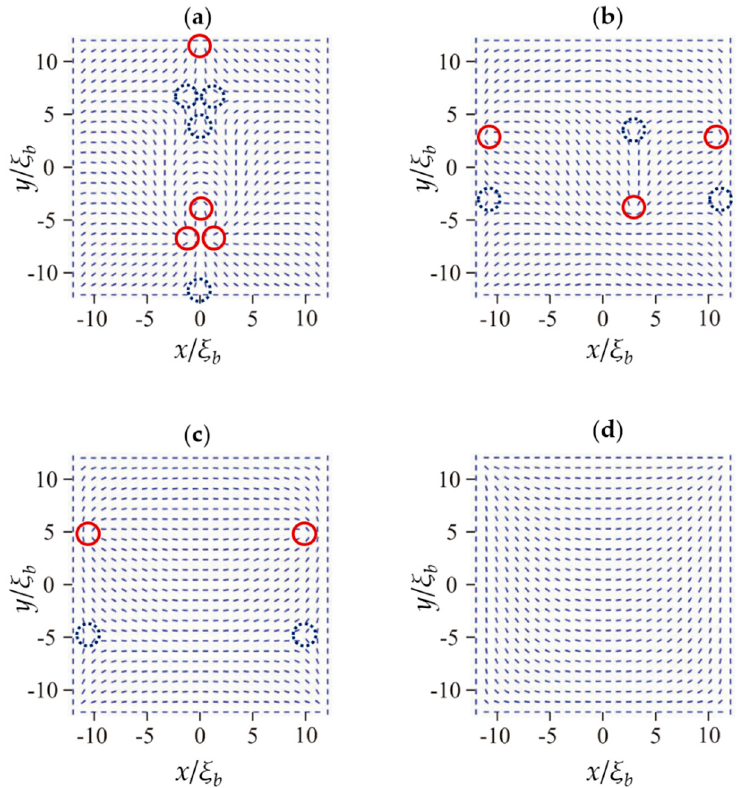
Figure 5. Annihilation by decreasing the surface anchoring field strength. Selected qualitatively di ff erent director profiles are shown. ( a ) µ w = 1.0, ( b ) µ w = 0.3, ( c ) µ w = 0.1, ( d ) µ w = 0.0. R / ξ b = 25, t = − 8. TDs bearing m = 1 / 2 and m = − 1 / 2 are indicated by red and blue circles, respectively.